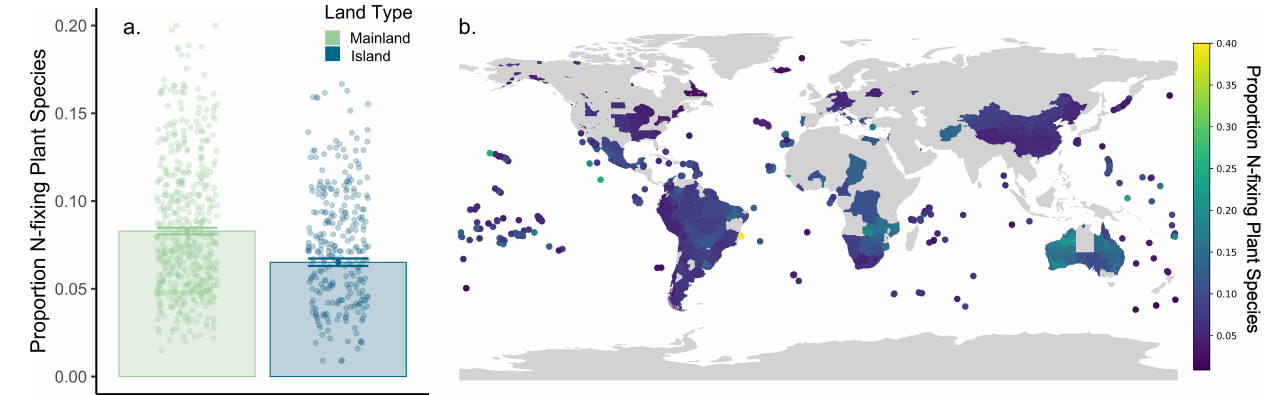
Fig. 1 N- fi xing plant species are underrepresented on oceanic islands. The proportion of N- fi xing plant species is signi fi cantly lower on oceanic islands compared to mainlands for all vascular plant species (GLM, a , p < 0.001, N = 1005). Map of proportion N- fi xing plant species at locations included in the study ( b ), with dark blue indicating lowest, and yellow indicating highest, proportion N- fi xing plant species. Error bars represent standard errors.